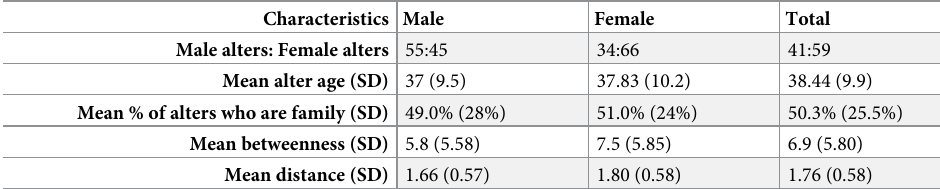
Table 3. Mean network characteristics of study participants across all